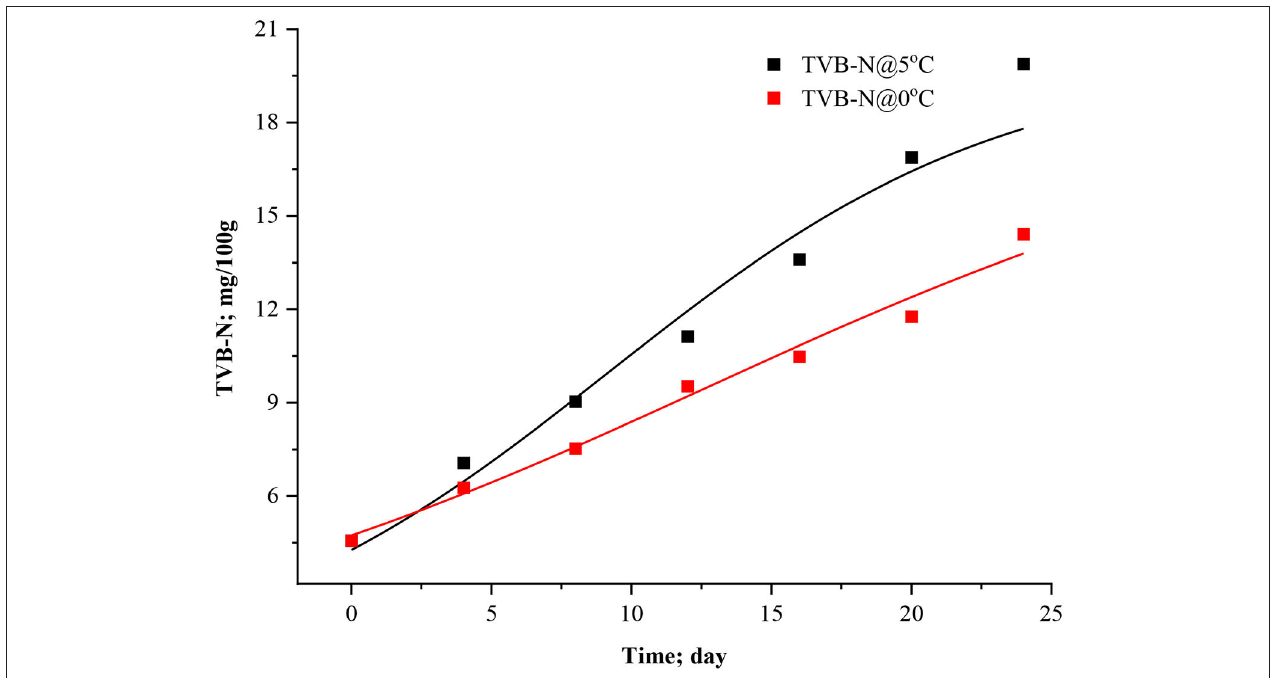
FIGURE 4 | Adapted Howgate model curve for TVB-N in stored Rohu